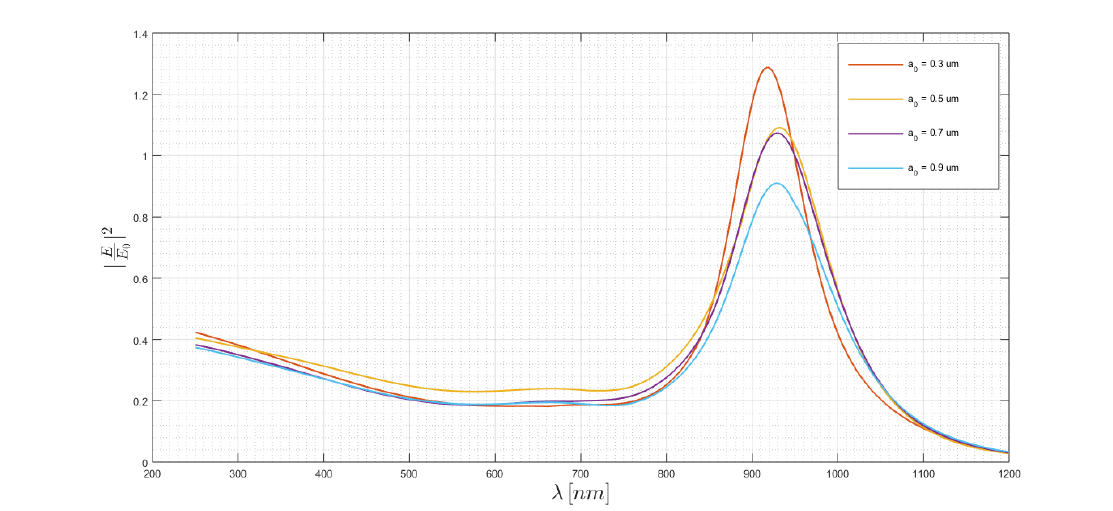
Figure 4. Periodicity sweep on the gold